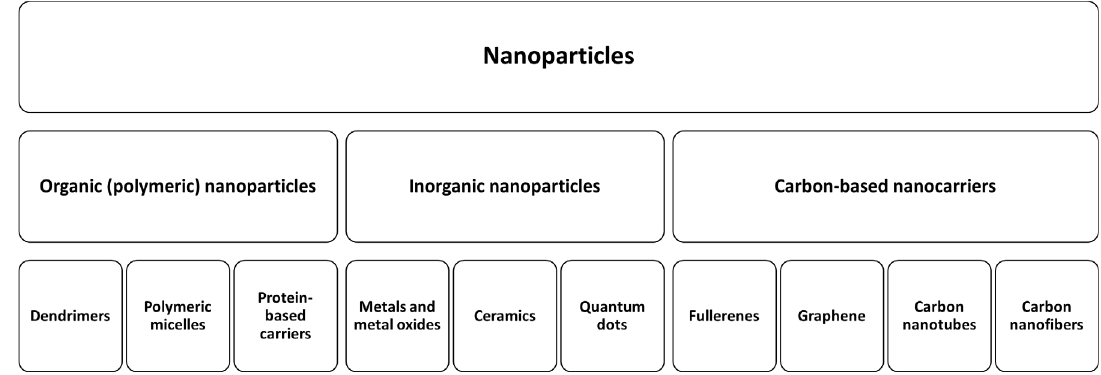
Figure 6. Classification of nanoparticles.